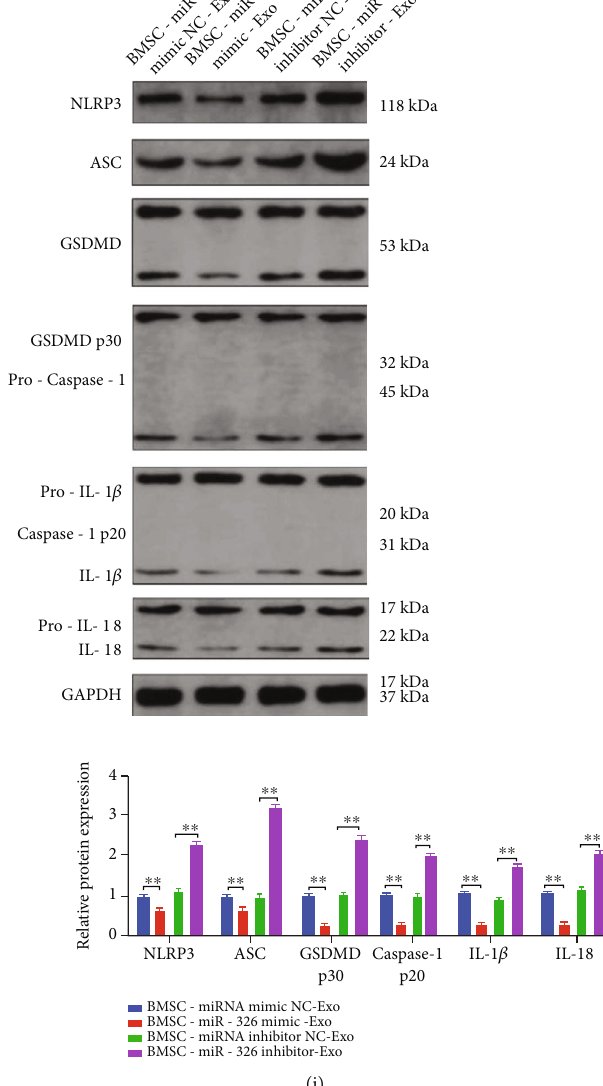
Figure 4: Exosomes extracted from miR-326-overexpressed BMSCs signi fi cantly inhibited pyroptosis, HDAC3 expression, and STAT1/NF- κ B p65 signaling pathway activation in OA chondrocytes, while silencing miR-326 had the opposite e ff ect. (a) Exosomes extracted from miR-326-overexpressed BMSCs signi fi cantly promoted proliferation of OA chondrocytes, while silencing miR-326 had the opposite e ff ect; (b) exosomes extracted from miR-326-overexpressed BMSCs signi fi cantly promoted migration of OA chondrocytes, while silencing miR-326 had the opposite e ff ect; (c) exosomes extracted from miR-326-overexpressed BMSCs signi fi cantly increased the mRNA levels of chondrogenic speci fi c genes (COL2A1, SOX9, Agg, and Prg4) in OA chondrocytes, while silencing miR-326 had the opposite e ff ect; (d) exosomes extracted from miR-326-overexpressed BMSCs signi fi cantly decreased the levels of proin fl ammatory factors (IL-1 β , IL-18, IL-6, and TNF- α ) in OA chondrocytes, while silencing miR-326 had the opposite e ff ect; (e) exosomes extracted from miR-326- overexpressed BMSCs signi fi cantly decreased DNA-binding activity of NF- κ B p65 in OA chondrocytes, while silencing miR-326 had the opposite e ff ect; (f) exosomes extracted from miR-326-overexpressed BMSCs signi fi cantly decreased Caspase-1 activity in OA chondrocytes, while silencing miR-326 had the opposite e ff ect; (g) immuno fl uorescence results showed that exosomes extracted from miR-326-overexpressed BMSCs signi fi cantly decreased the levels of GSDMD and cl-Caspase-1 in OA chondrocytes, while silencing miR- 326 had the opposite e ff ect; (h) Western blot results showed that exosomes extracted from miR-326-overexpressed BMSCs signi fi cantly decreased the level of HDAC3 and activated the STAT1/NF- κ B p65 signaling pathway in OA chondrocytes, while silencing miR-326 had the opposite e ff ect; (i) Western blot results showed that exosomes extracted from miR-326-overexpressed BMSCs signi fi cantly decreased the levels of pyroptosis-related proteins (NLRP3, ASC, GSDMD, Caspase-1, IL-1 β , and IL-18) in OA chondrocytes, while silencing miR- 326 had the opposite e ff ect; ∗ P < 0 : 01 , ∗∗ P < 0 : 01